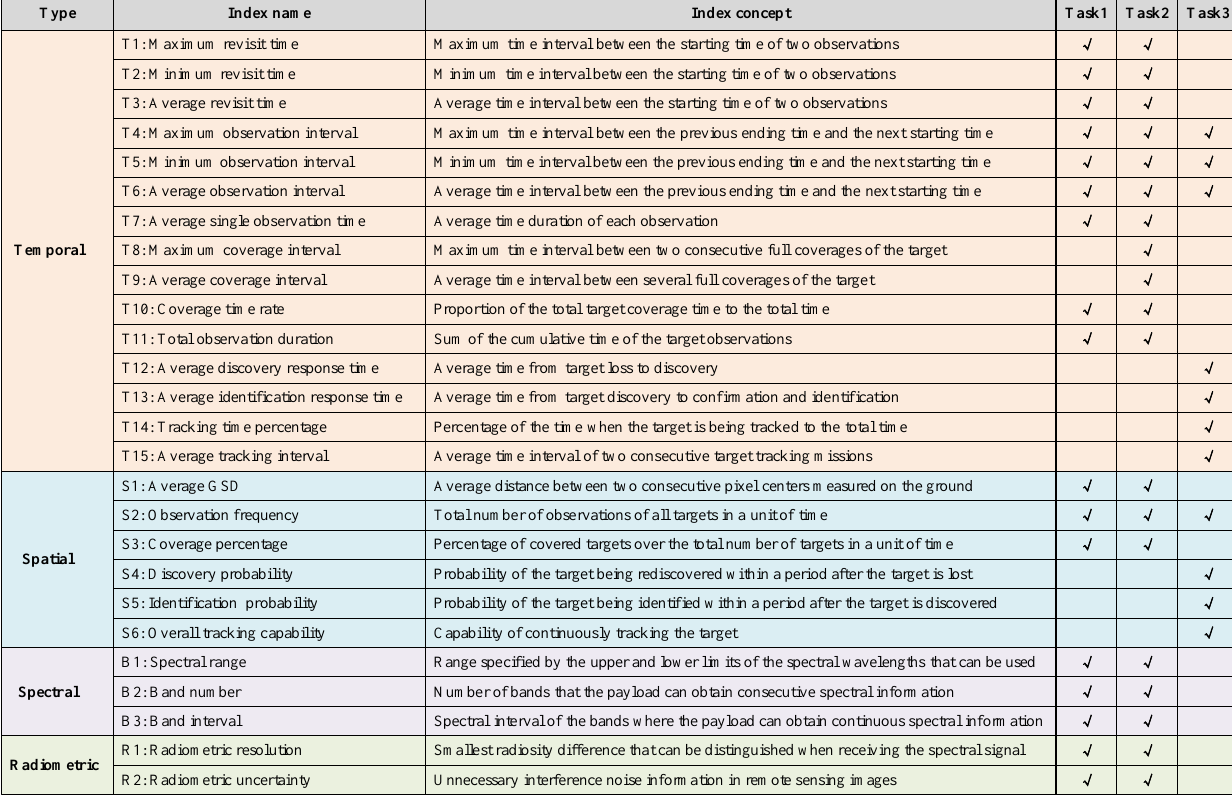
Figure 4. Results of index decomposition and clustering.